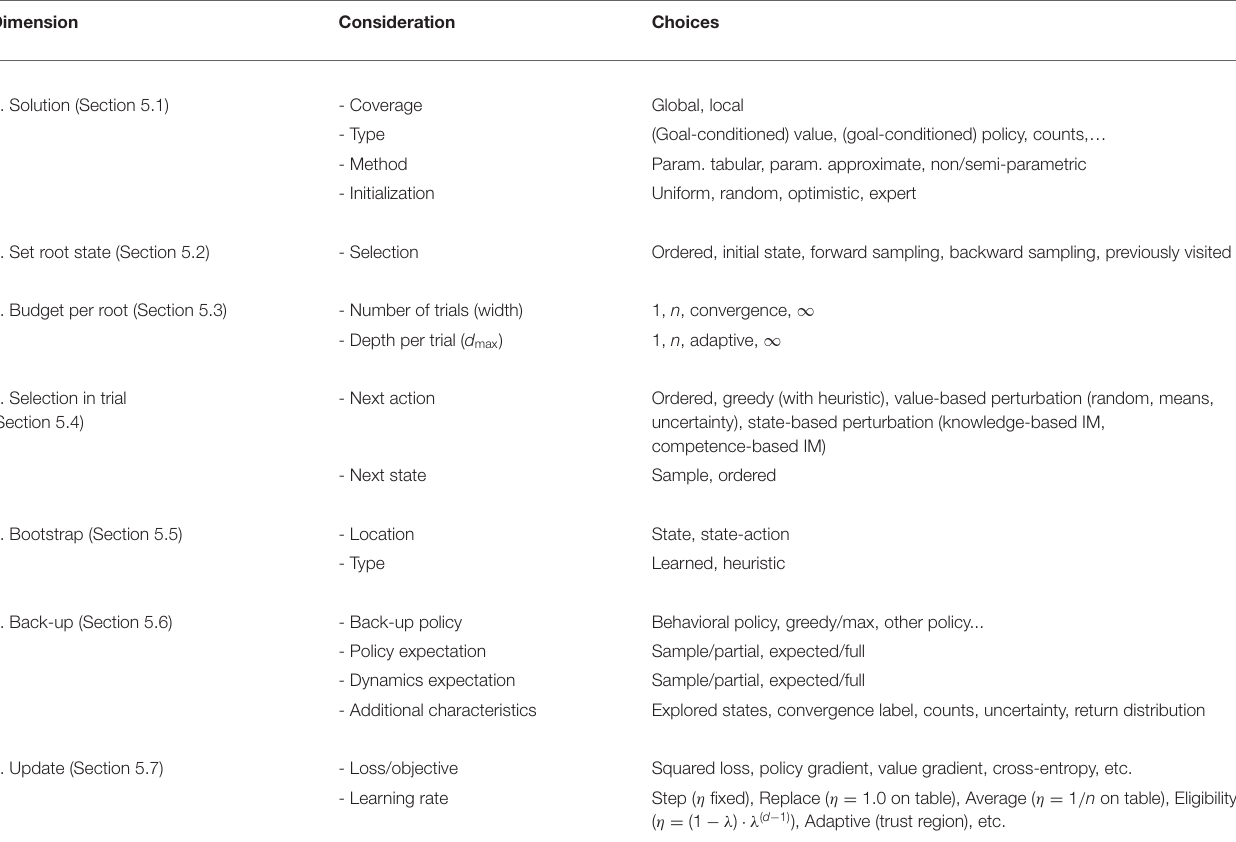
TABLE 2 | Overview of dimensions in the Framework for Reinforcement learning and Planning (FRAP).